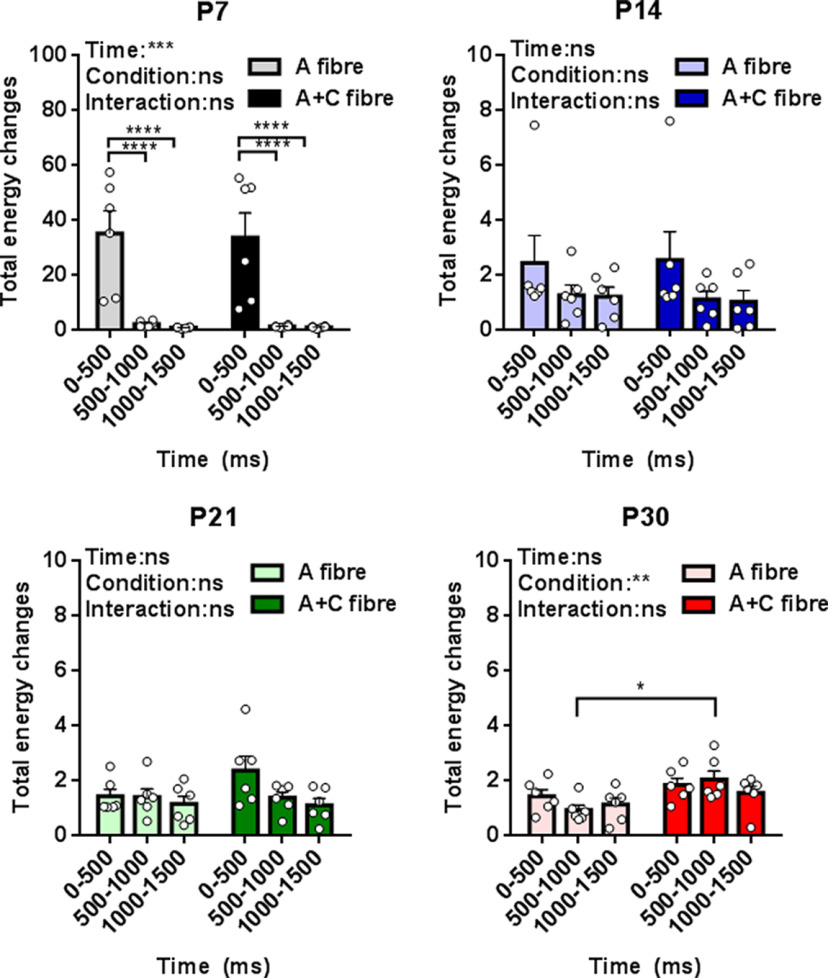
Maturation of total energy changes in neuronal oscillations in S1 following contralateral hindpaw skin stimulation. Total energy changes evoked by A fiber (50 μs) and A + C fiber (500 μs) electrical stimulation of the contralateral hindpaw at postnatal day (P)7, P14, P21, and P30 between 0 and 500, 500 and 1000, and 1000 and 1500 ms poststimulation. Mean (±SEM) total energy changes (compared with baseline) following electrical stimuli (10 stimuli at 10-s ISI, 3.2 mA, n = 6 rats at each age). Each dot represents the average across stimuli for each rat. Two-way RM ANOVA (summary results are shown on top left of each panel) with Sidak’s multiple comparisons test; *p < 0.05, **p < 0.01, ***p < 0.001, ****p < 0.0001, and ns: not significant.